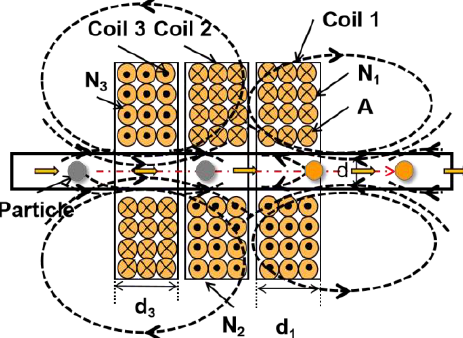
Figure 1. Schematic diagram of the sensor. The schematic diagram of the micro-three-coil sensor is shown in Figure 2. Metal particles in an alternating magnetic field produce magnetization and eddy current effects, causing changes in the inductance and impedance of the coil [22–26].